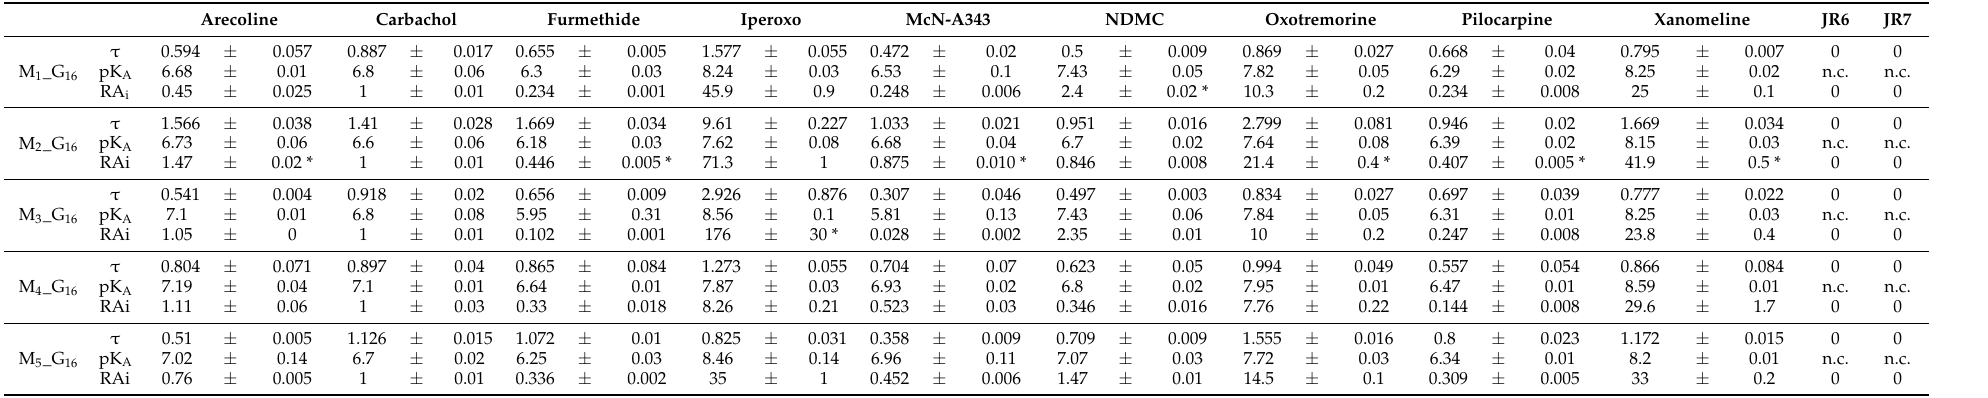
Table 2. Parameters of functional response of G α 16 _fused receptors. Operational efficacy τ , agonist equilibrium dissociation constant K A, and agonist relative intrinsic activity R Ai were calculated according to Equations (6)–(8), respectively, from parameters of functional response EC 50 and E ´ MAX (Supplementary Material, Table S3) obtained by fitting Equation (5) to data from measurement of the accumulation of inositol phosphates. Values of system E MAX are (27.1 ± 0.5 for M 1 _G α 16 ; 30.7 ± 0.603 for M 2 _G α 16 ; 27.1 ± 0.6 for M 3 _G α 16 ; 27.1 ± 1.2